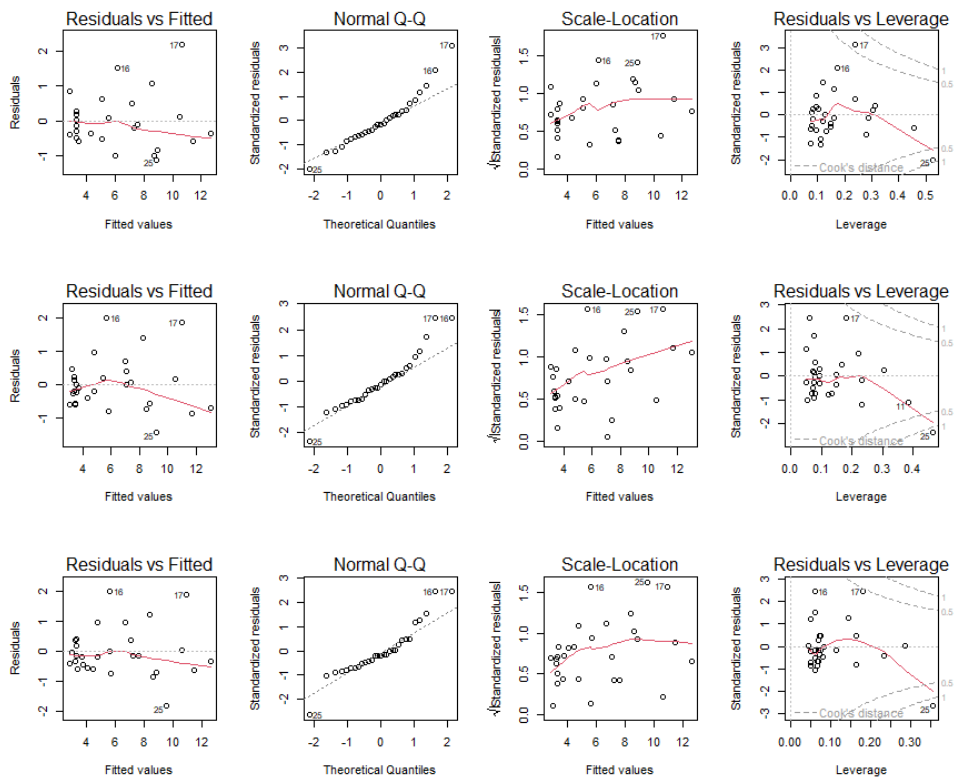
Figure A4. Goodness − of − fit of the biceps curl 1 − RM equation models.